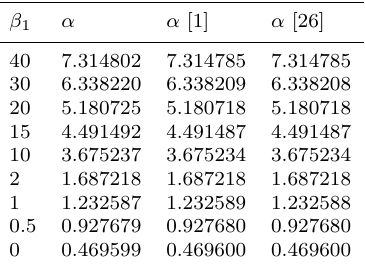
Table 3. The wall shear stress α = f (cid:48)(cid:48) (0) of Falkner-skan model with β 0 = 1 compared to Asaithambi’s [1] and Salama’s [26] solutions. β 1